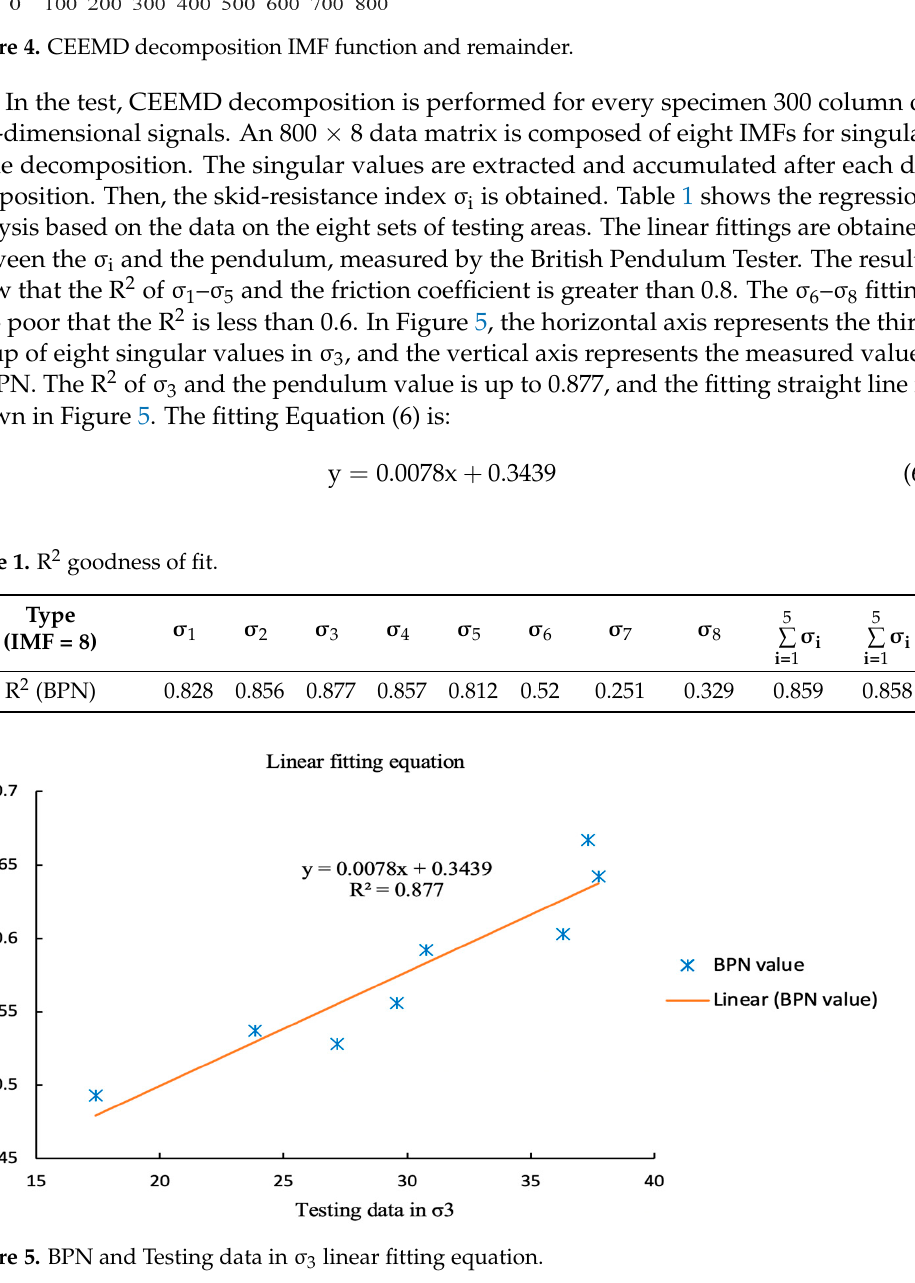
Figure 5. BPN and Testing data in σ (cid:2871) linear fitting equation.